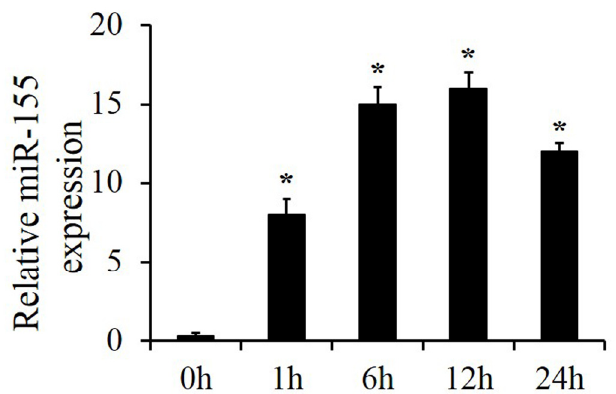
Figure 1. MiR-155 expression increased in smoke-induced acute lung injury (ALI). ALI was induced in mice by smoke. After recovery for the indicated time periods (0, 1, 6, 12 and 24 h), lung RNA levels of miR-155 were analyzed by real-time RT-PCR. n = 4 samples per group. * p < 0.05 vs. 0 h.